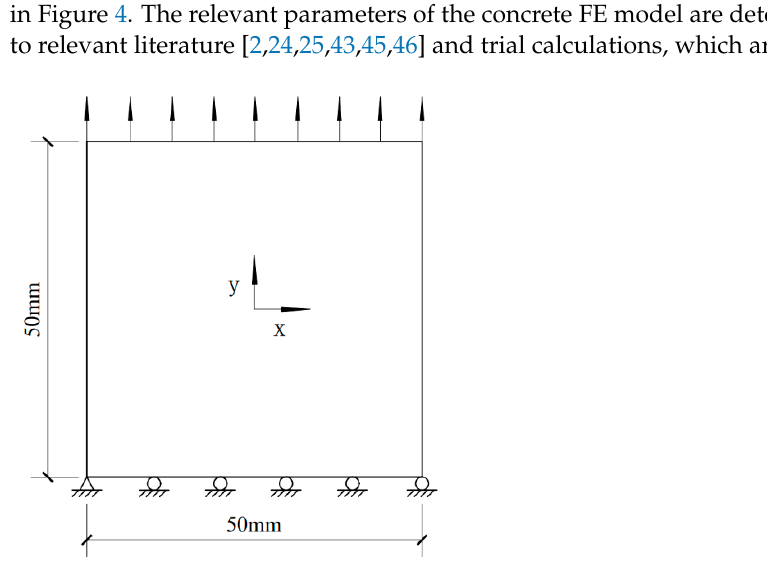
Figure 4. Loads and boundary conditions for uniaxial tensile tests. Table 3. Material properties of the concrete mesoscopic FE model. Bulk Elements Cohesive